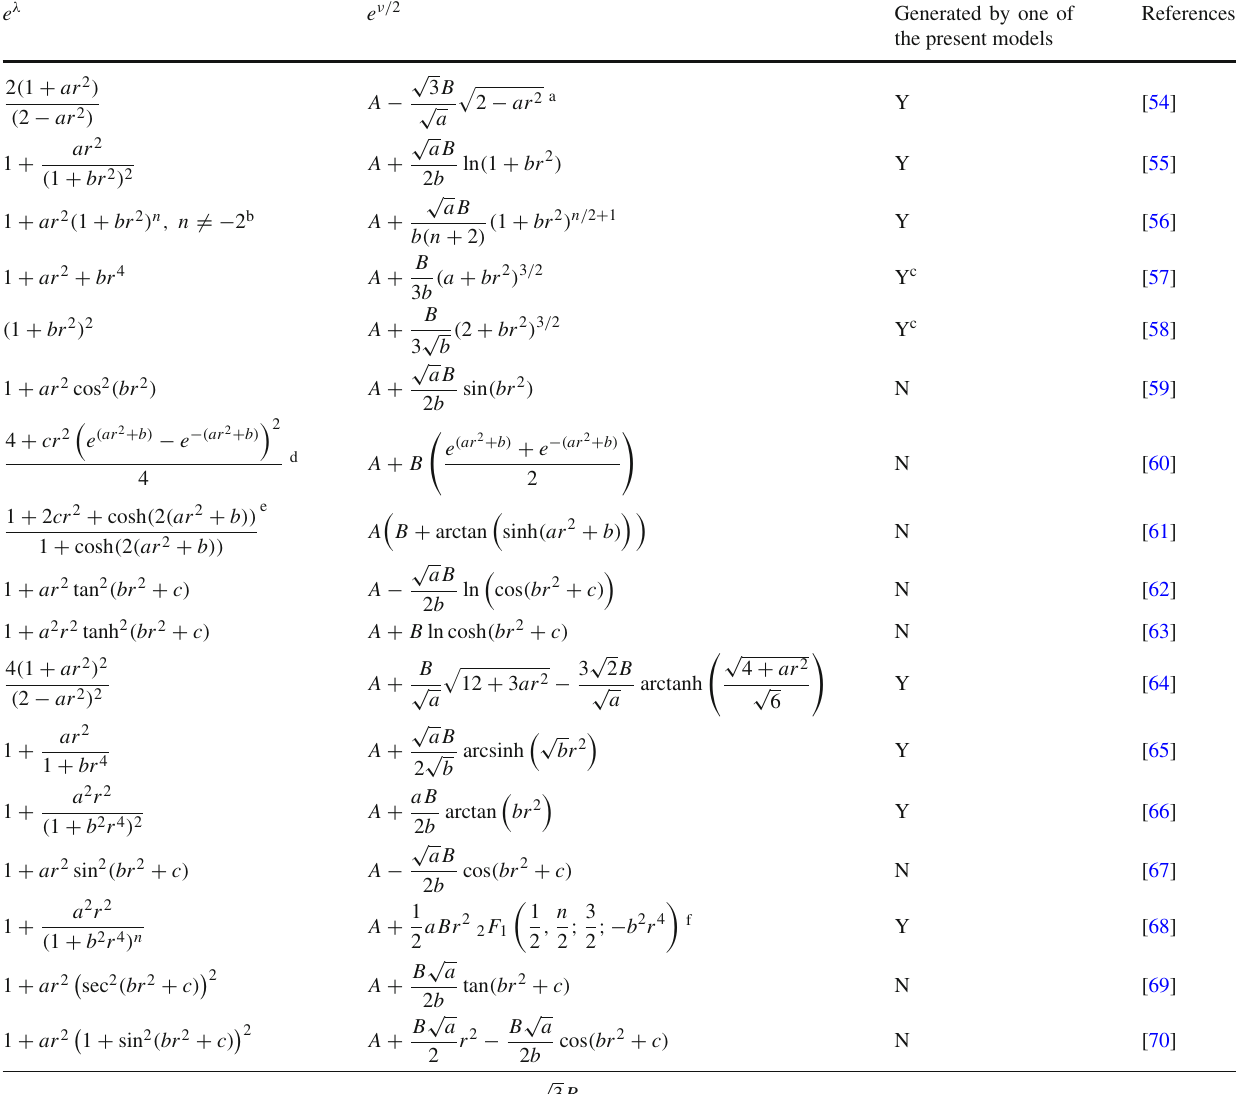
Table 1 List of particular form of generating function f that generates exact static spherically symmetric class 1 solutions satisfying the Eiesland condition e λ e ν/ 2 Generated by one of